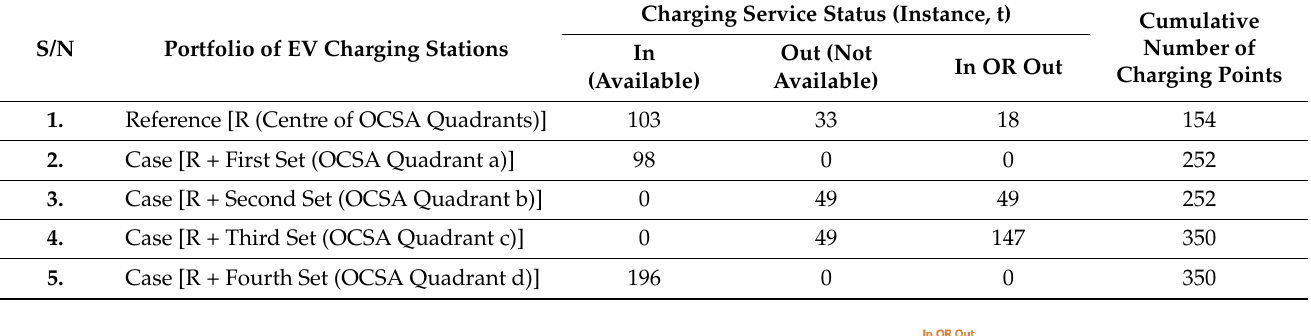
Table 5. Portfolios of EV Charging Stations and Charge Service Statuses: Figure 16.